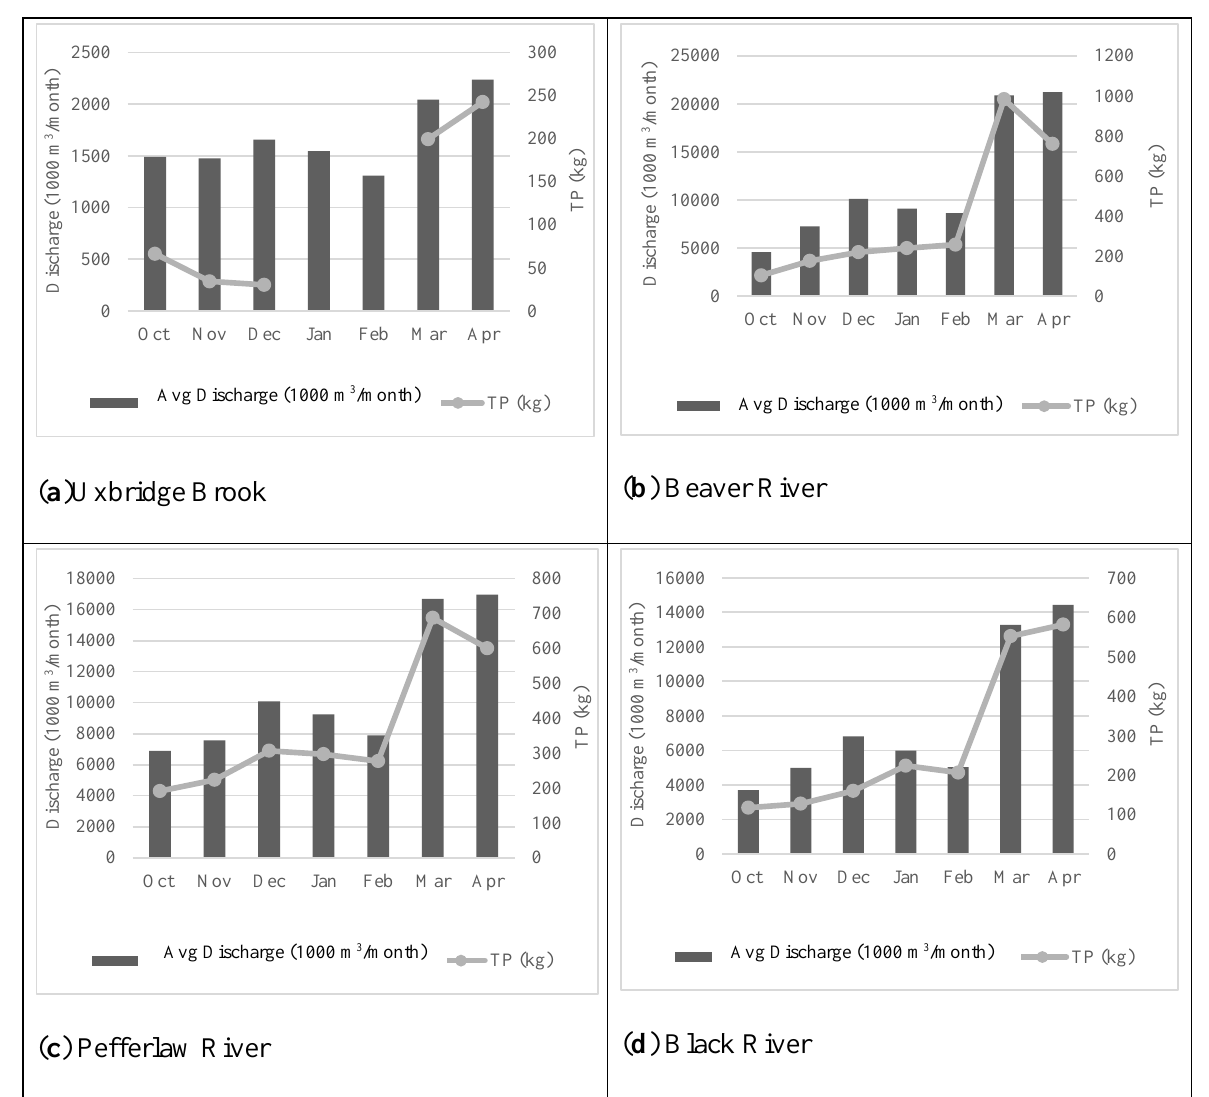
Figure 1: Average discharge (1000 m 3 /month) (Government of Canada, 2020) with total phosphorus (TP) (kg) from 2011 – 2016 for the Uxbridge Brook (a), Beaver River (b), Pefferlaw River (c), and the Black River (d) [6].